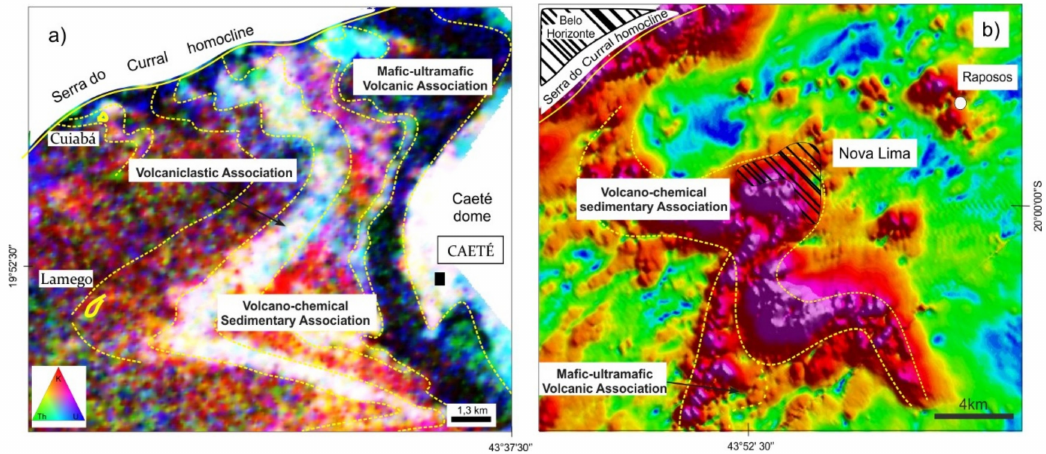
Figure 12. ( a ) Airborne radiometric map (Ternary RGB image) of the western portion of the Rio das Velhas greenstone belt, Quadril á tero Ferr í fero. In white felsic volcanic and volcaniclastic units; ( b ) magnetic map (analytical signal) of the area near the town of Nova Lima. Major geological boundaries are indicated. Mafic volcanic rocks, with BIF, may be inferred from highest magnetic portions (in bright red / purple). Maps obtained from